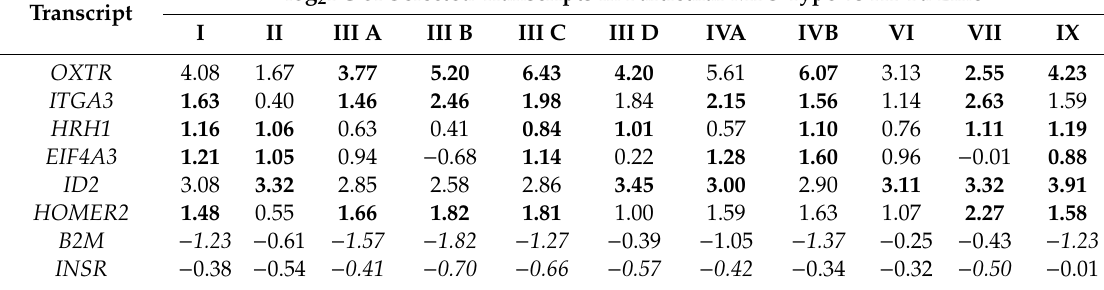
Table 4. Changes in expression (transcripts’ levels) of particular genes in MPS types are depicted, indicating log 2 fold change (FC) relative to control cells (HDFa); up-regulation is marked in bold and down-regulation in marked in italic, while not statistically significant di ff erences are not